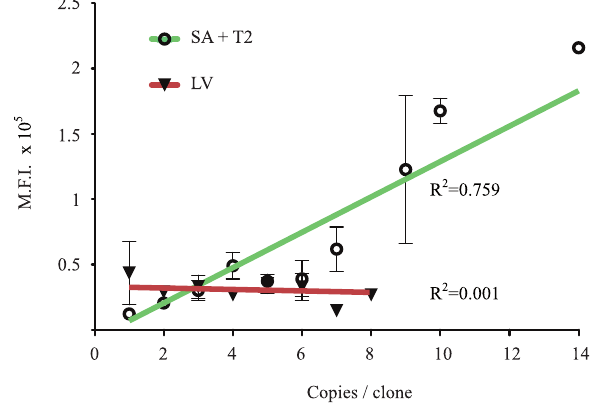
Figure 4. Correlation between copy number and expression of the integrated cassette. Mean fluorescence intensity (M.F.I.) of 62 GABEB clones positive for Venus expressing SB transposons are represented as circles; triangles indicate the M.F.I. of 70 GFP + HaCaT clones transduced with a lentiviral vector (LV). Standard deviation bars are present for those clones carrying the same copy number. R 2 coefficients of determination were extracted from the linear regression plot, green line for SA and T2 transposons and red line for